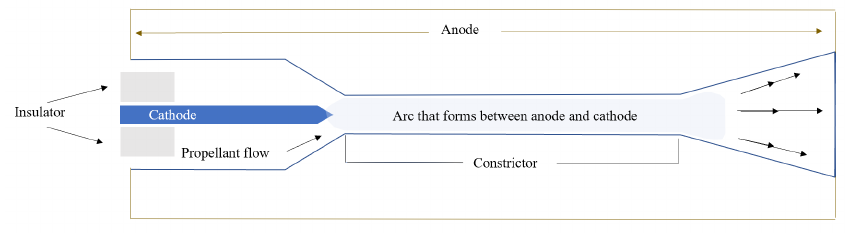
Figure 8. An arcjet thruster as a simplified schematic